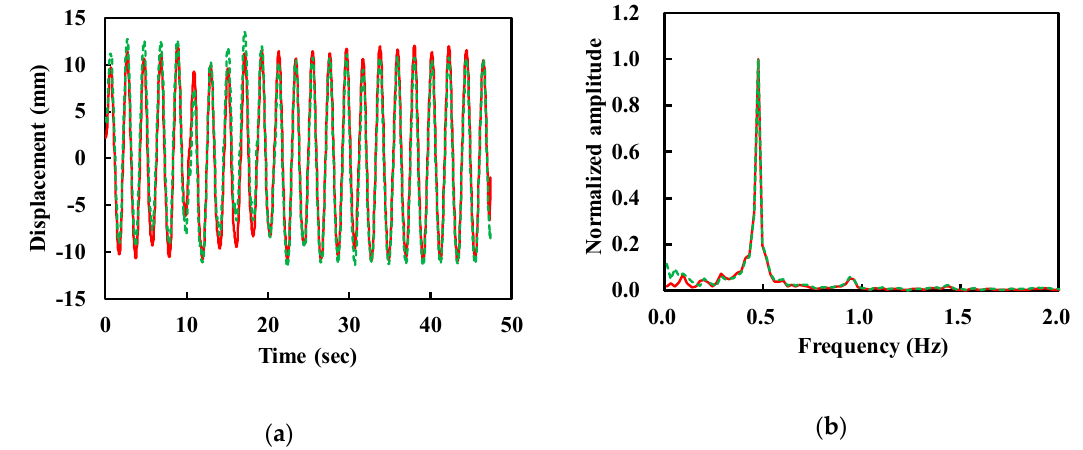
Figure 8. Demodulated ( x d [ n ] , dashed) and trend-removed signals ( x d , t [ n ] , solid). ( a ) Time domain waveforms. ( b ) Normalized amplitude in frequency domain.